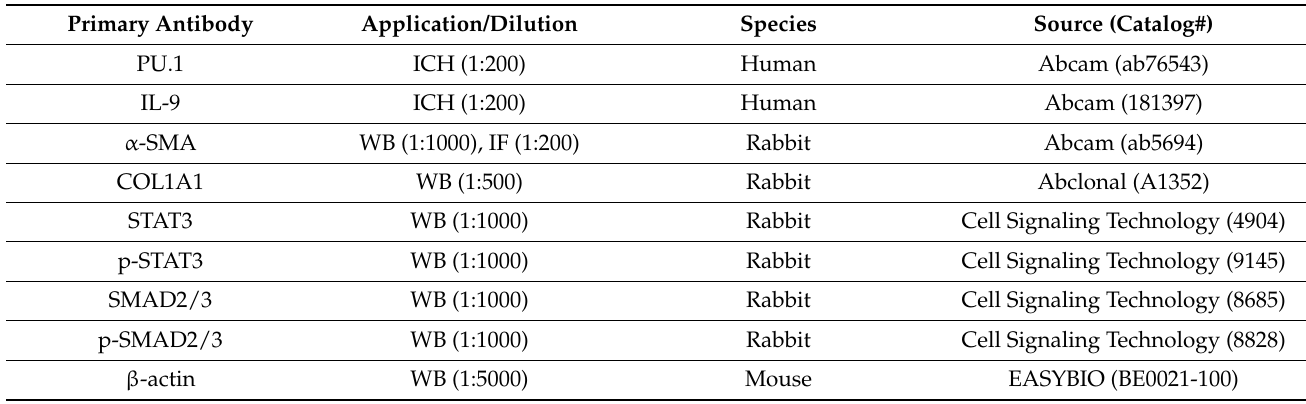
Table 4. Antibody